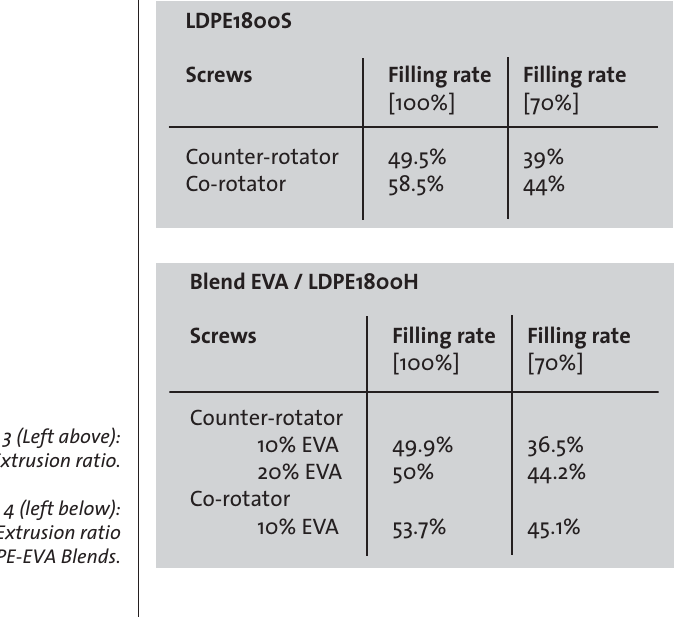
Table 3 (Left above): Extrusion ratio. Table 4 (left below): Extrusion ratio PE-EVA